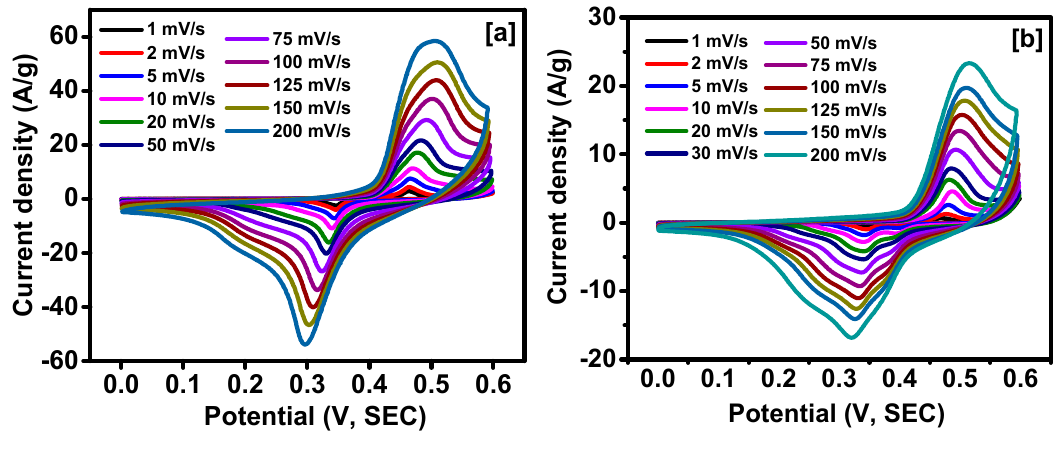
Figure 4. Raman spectra of ( a ) MWCNTs ( b ) GONRs, ( c ) PPy, ( d ) 0.5 PPyGONR, ( e ) 1.5 PPyGONR, and ( f ) 3